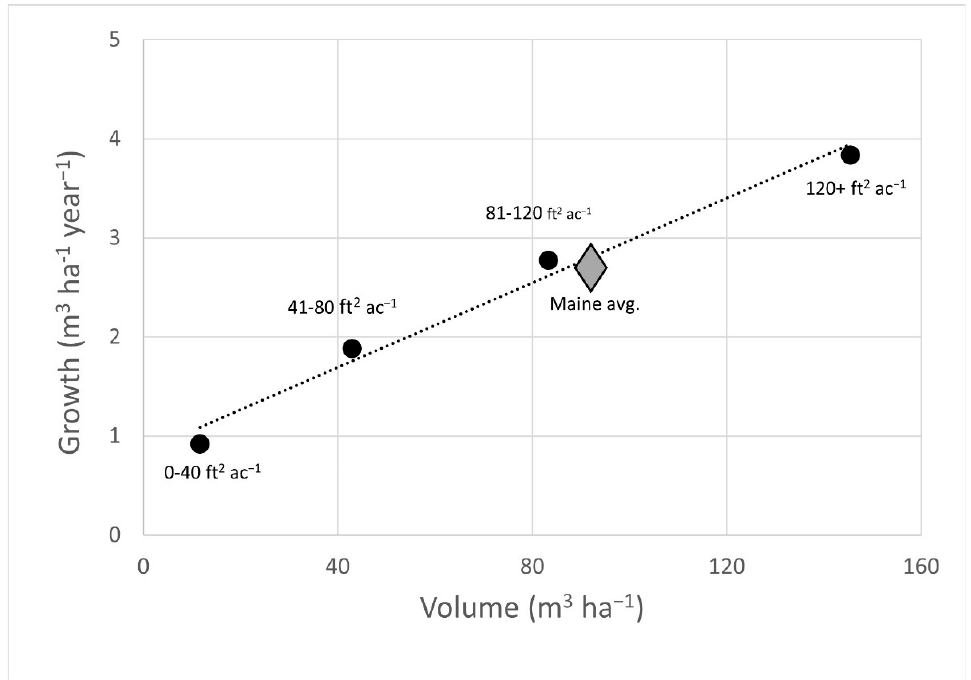
Figure 3. Growth as a function of volume of growing stock for Maine forests. Round dots represent mean growth versus mean volume summarized by basal area stocking class, based on queries of 2019 Forest Inventory and Analysis (FIA) program data for Maine using the U.S. Department of Agriculture Forest Service Evalidator program. (Basal area stocking classes are defined by FIA in ft 2 ac − 1 , as shown.) The gray diamond represents the statewide average for Maine (including all forest types). Growth is average annual net growth of merchantable bole volume of growing-stock trees at least 12.7 cm dbh (diameter at breast height) on timberland; volume is net merchantable bole volume of growing-stock trees at least 12.7 cm dbh on timberland. Refined from Seymour (pers. comm.).